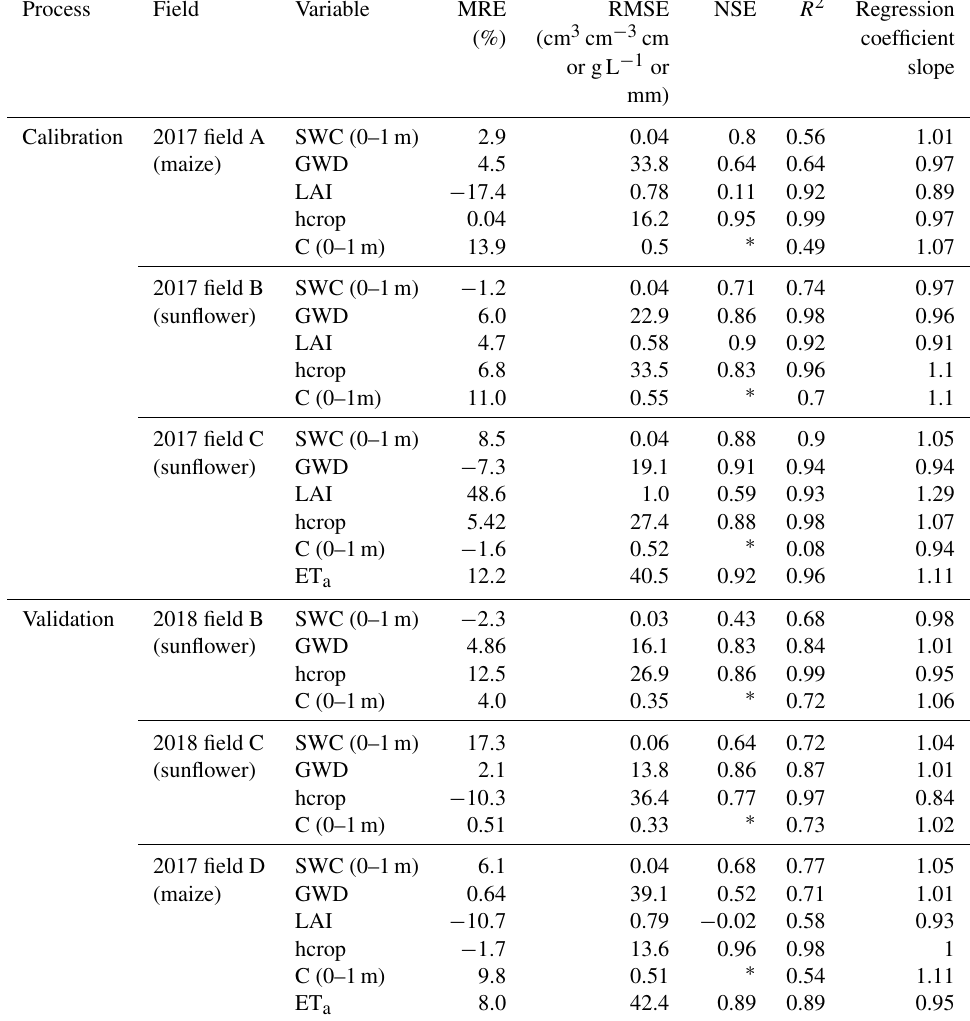
Table 4. Model error statistics for calibration and validation of models in 2017 and 2018 (mean relative error, MRE; root mean square error, RMSE; Nash–Sutcliffe efficiency, NSE; coefficient of determination, R 2 ; regression